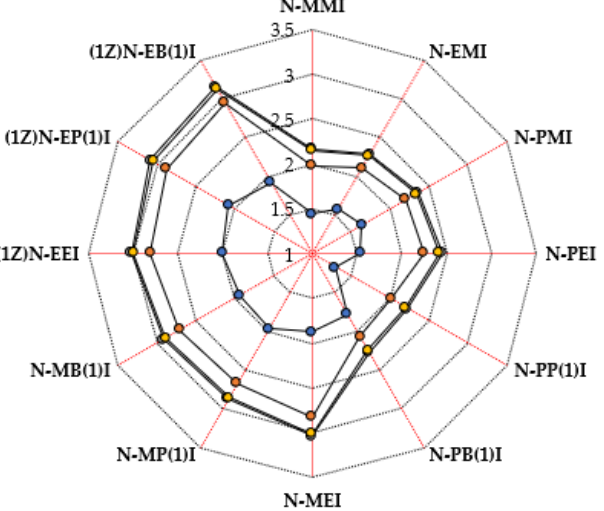
Figure 8. The dipole moment of the investigated Schiff bases in the gas phase (blue line), aqueous phase (orange line) and HCl environment with a concentration of 1 mol/dm3 (yellow line) and 2 mol/dm 3 (grey line).